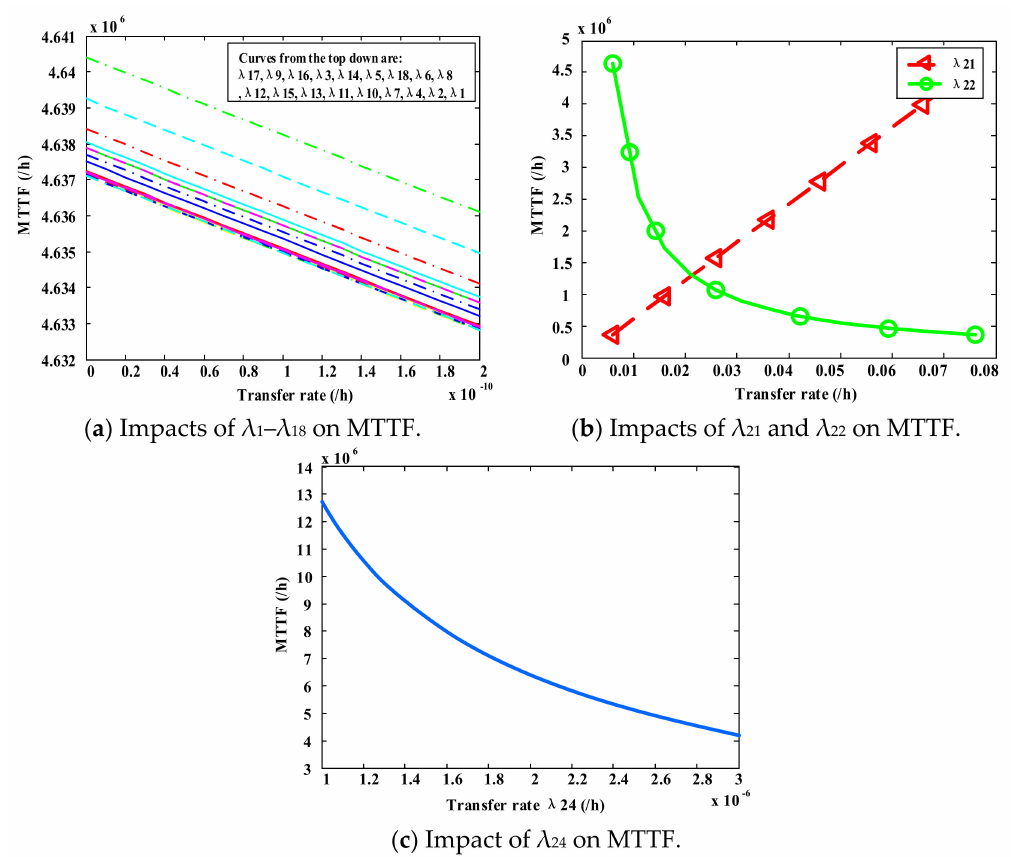
Figure 12. Impacts of transition rates λ 1 – λ 18 ( a ), λ 21 and λ 22 ( b ) and λ 24 ( c ) on